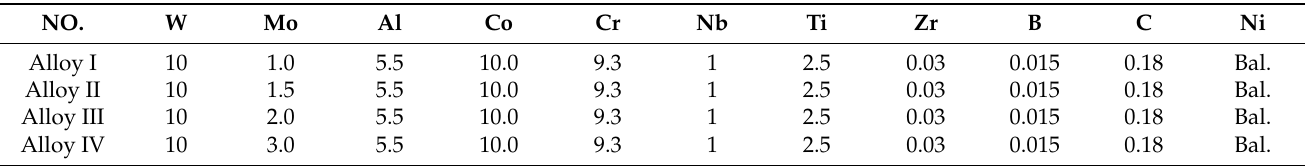
Table 1. Chemical compositions of experimental alloys (mass fraction,